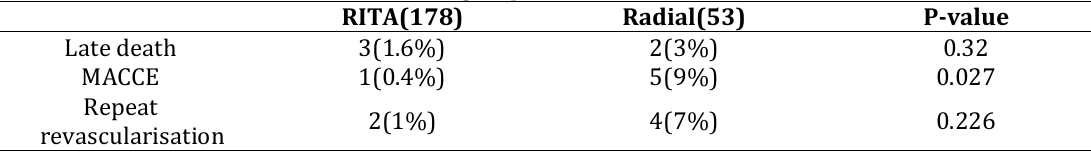
Table 4. Late events between RITA and RA